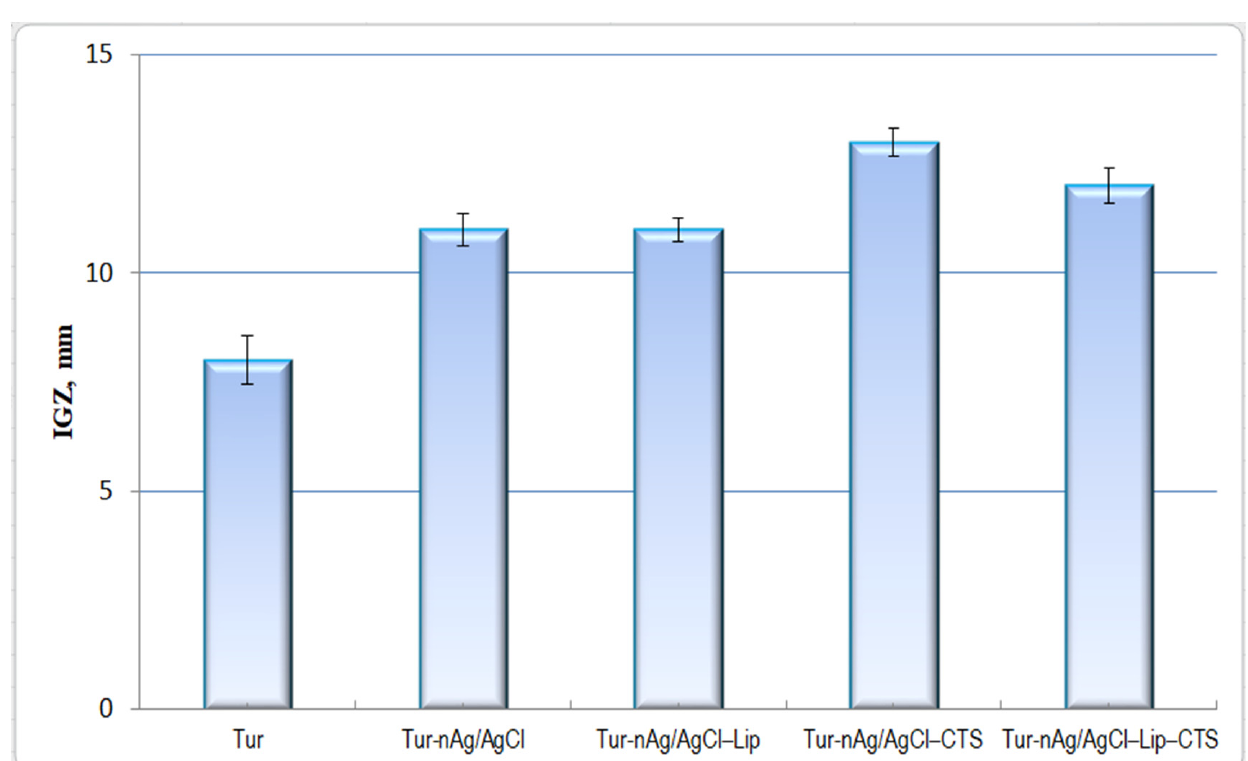
Figure 9. Antibacterial effect of developed materials against Enterococcus faecalis.